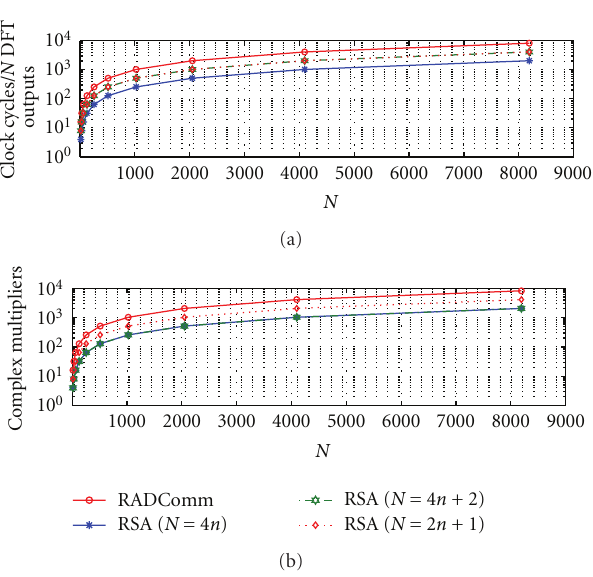
Figure 6: Throughput and complex multiplier requirements for the RSA and RADComm implementations.